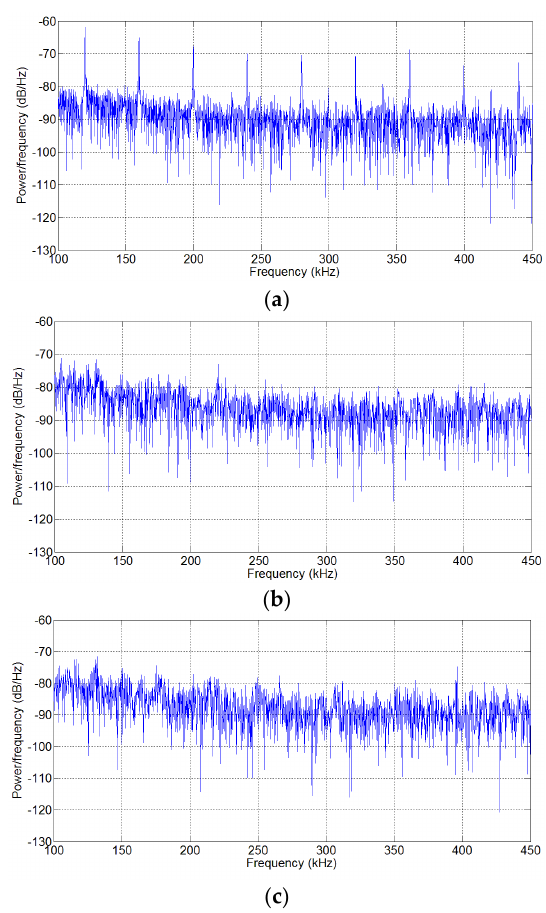
Figure 24. Measured power spectrum density of shifted-phase angle control: ( a ) fixed switching-frequency; ( b ) continuously chaotic modulation; ( c ) discretely chaotic modulation. The experimental verification is also given for the TPI bidirectional DC/DC converter with phase-shifted PWM control. The measured waveforms using fixed switching-frequency, continuously chaotic modulation and discretely chaotic modulation are shown in Figures 25–27, respectively. The chaotic modulation schemes can keep the output voltage U o stable in port 2 although they exhibit chaotic behaviors in high-frequency domain.